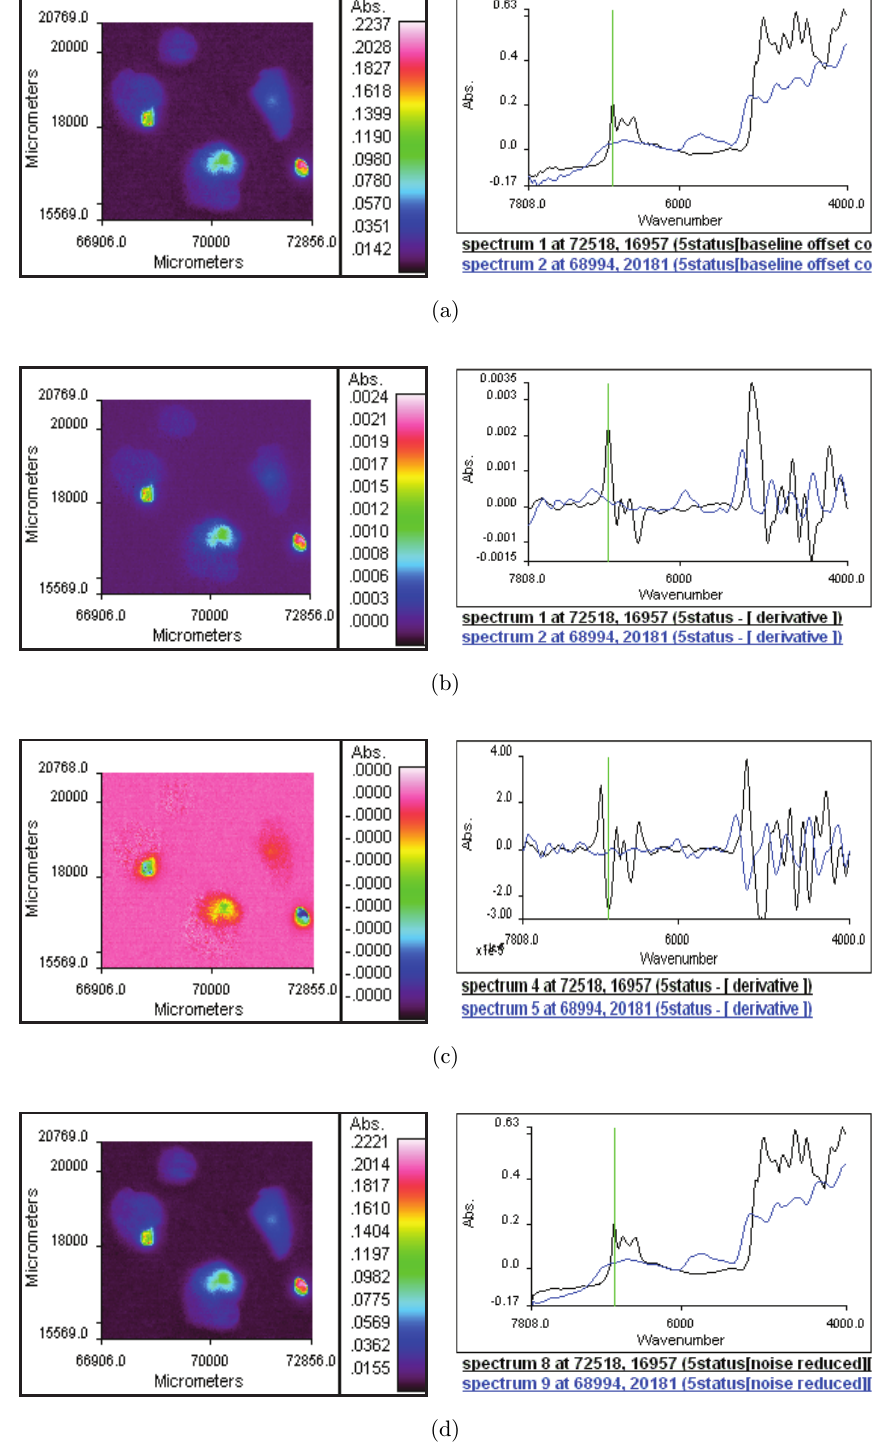
Fig. 3. Single wavelength images with di®erent preprocessing. (a) Baseline o®set correction (Single wavelength ¼ 6805 cm (cid:1) 1 Þ . (b) First derivative (Single wavelength ¼ 6854 cm (cid:1) 1 Þ . (c) Second derivative (Single wavelength ¼ 6805 cm (cid:1) 1 Þ . (d) Noise reduction and baseline o®set correction (Single wavelength ¼ 6805 cm (cid:1) 1 Þ